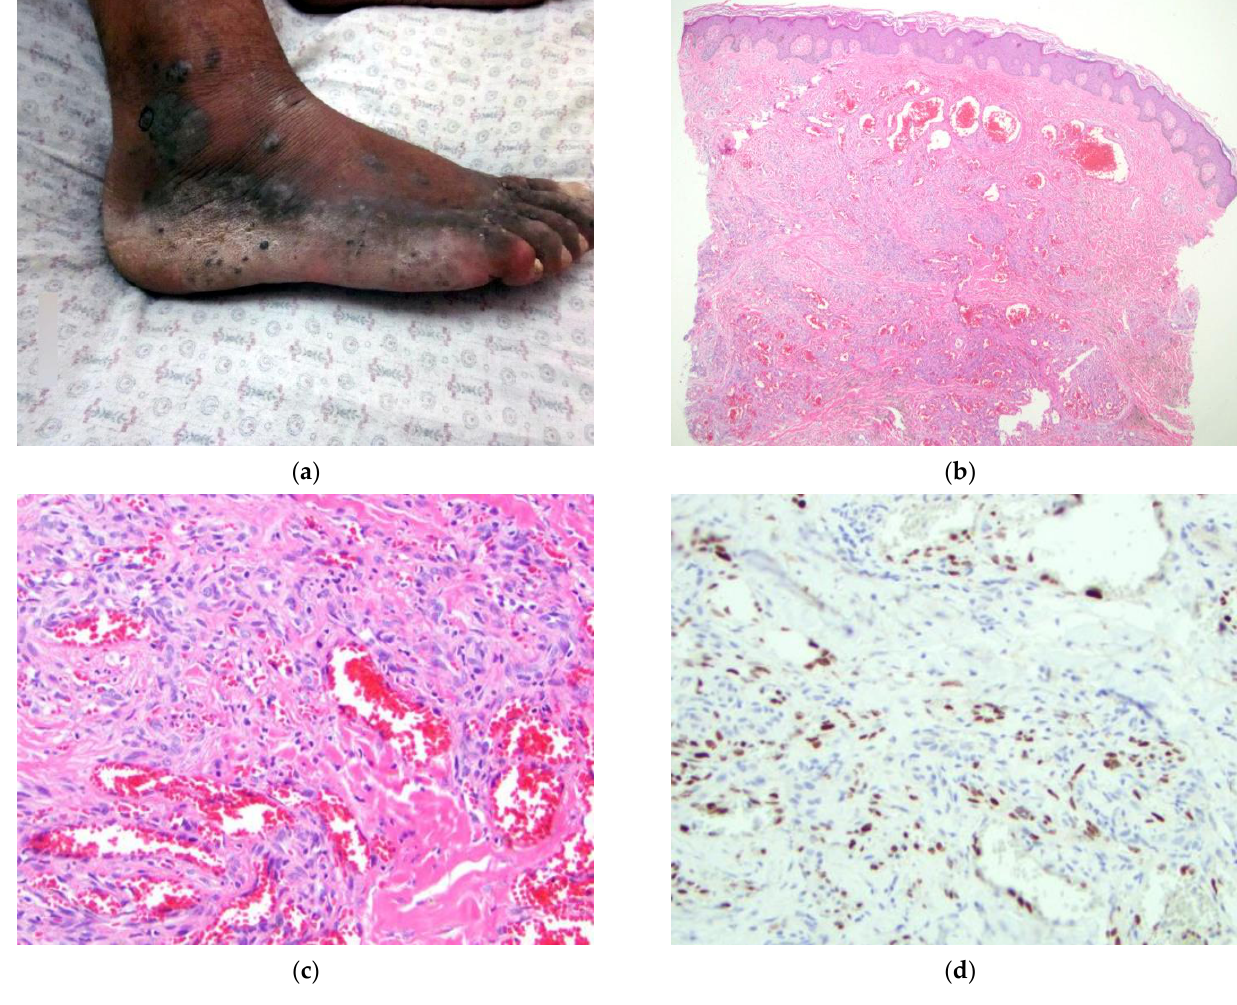
Figure 5. ( a – d ) Patient #5. Image ( a ) Multiple purple/black nodules and papules on the right lower extremity. Biopsy site shown. Image ( b ) H&E 40 × . Dilated vascular spaces of varying caliber within the superficial and deep dermis. Image ( c ) H&E 200 × . Bland nuclei with mild atypia forming slit-like vascular spaces. Image ( d ) IHC HHV-8 200 × . Scattered nuclear staining of spindled cells within the dermis.